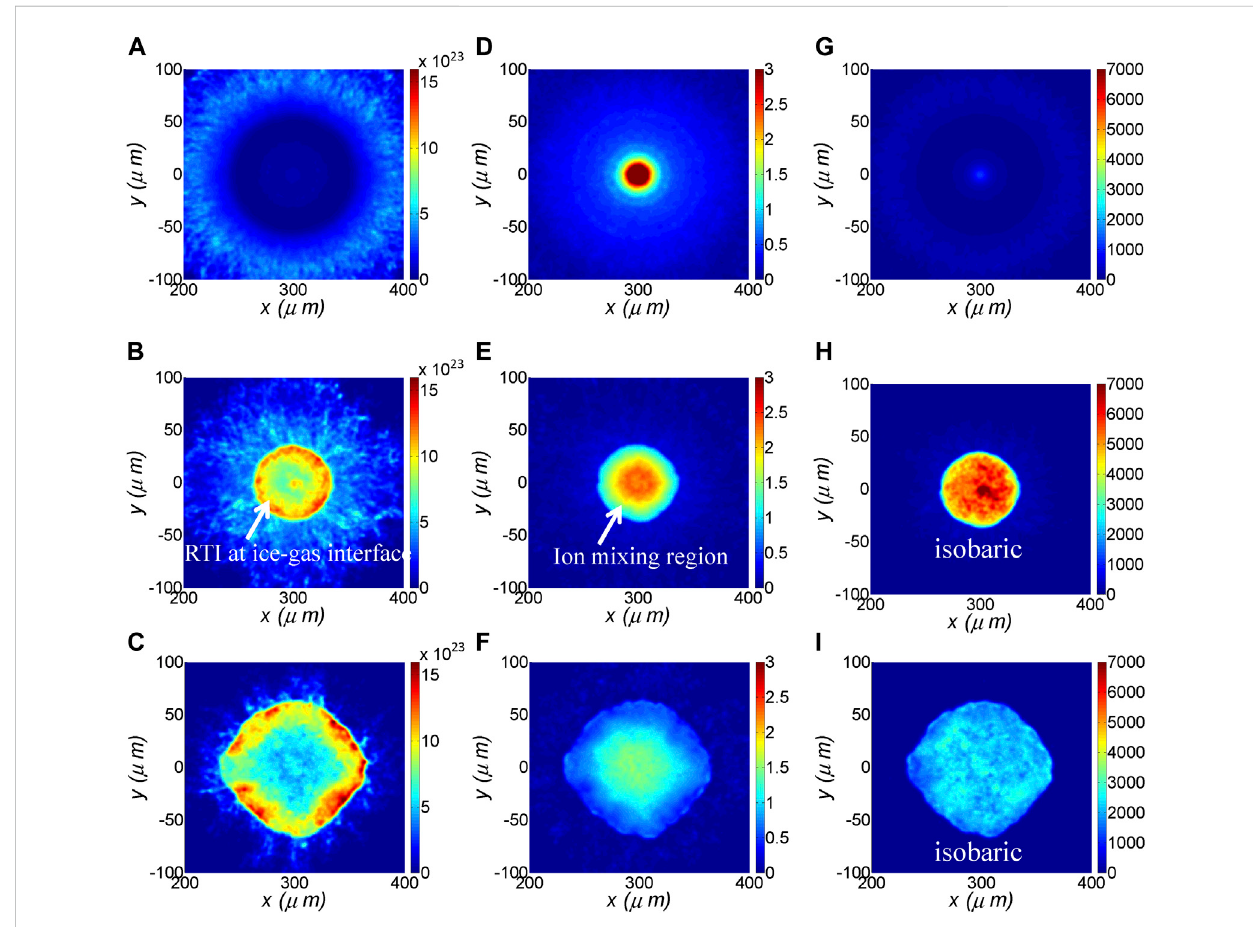
FIGURE 3 Snapshots of the2D density inunit of cm − 3 (A – C) , ion temperaturein unitof keV (D – F) , and pressure in unitof Mbar (G – I) atthree typicaltimes. The simulation uses 0.43 billion particles and applies a similar setup as RH